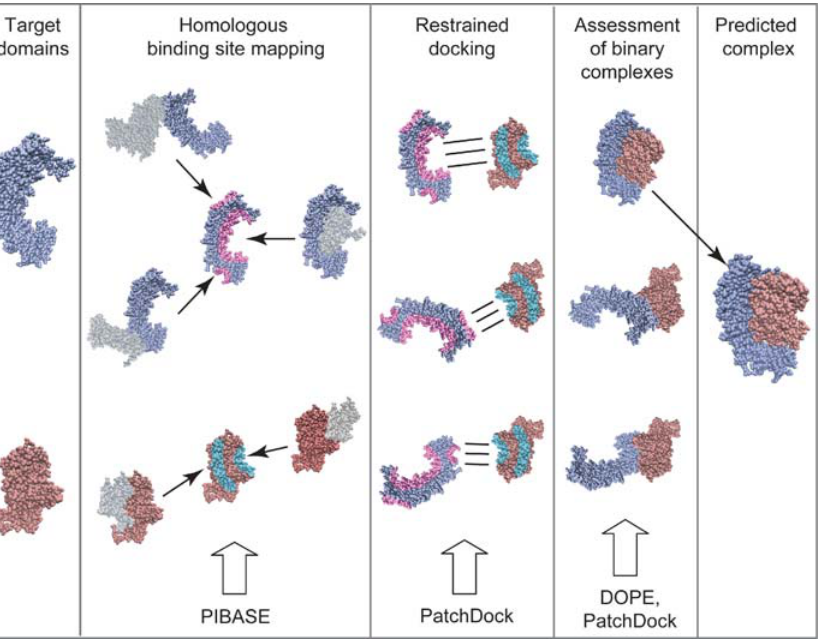
Figure 1. Basic Steps of Comparative Patch Analysis